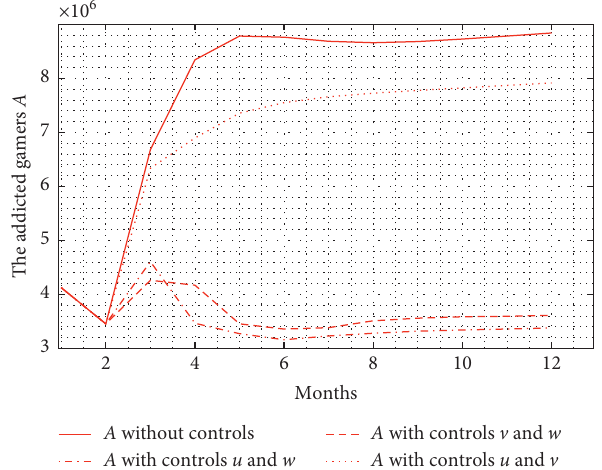
Figure 6: Development of the number of the addicted gamers with the combination of two controls among the controls u k , v k , and w k .